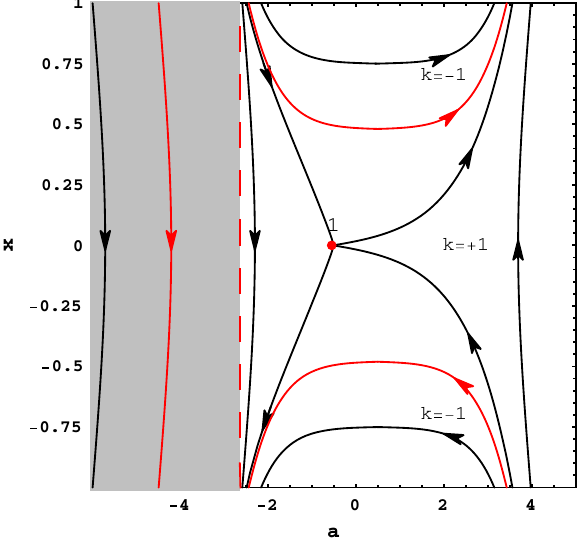
Fig. 3 The phase portrait for system (15)–(16) with f ( ˆ R ) = ˆ R + γ ˆ R + δ ˆ R 3 , where γ = − 10 − 6 Critical point (1), which is of saddle type, represents the static Einstein universe. The red dashed line presents the sudden singularity. The gray color presents the non-physical domain ( f (cid:3) ( R ) < 0). The red trajectories represent the path of evolution for the flat universe. These trajectories separate the domain with the negative curvature ( k = − 1) from the domain with the positive curvature ( k = + 1). The scale factor is expressed in a logarithmic